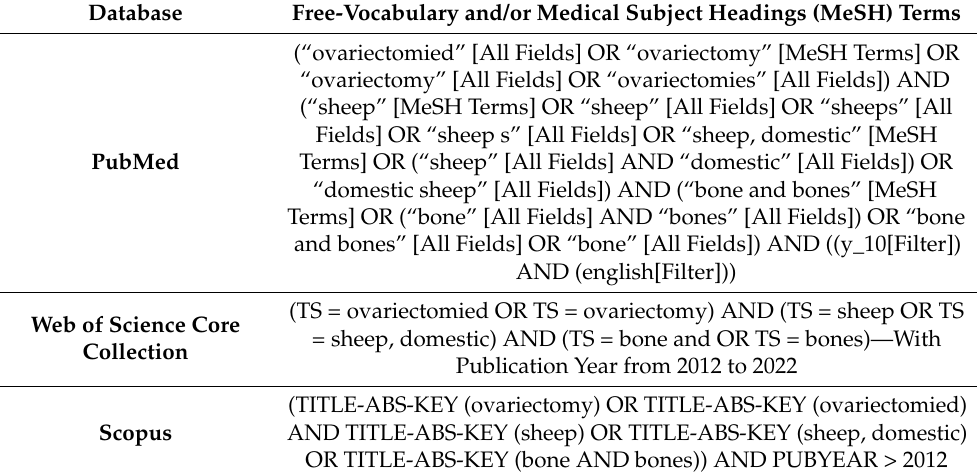
Table 1. Search terms used in the PubMed, Scopus, and Web of Science Core